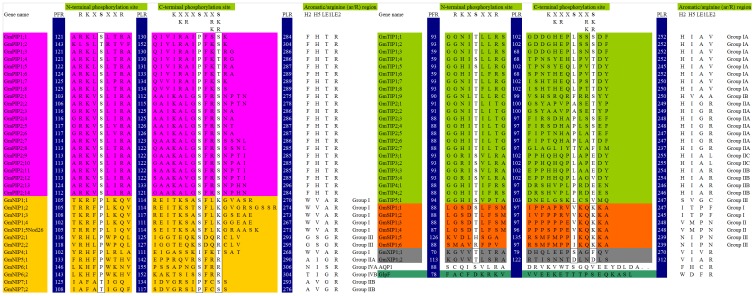
Phosphorylation sites in C-terminal domain, N-terminus and aromatic/arginine (ar/R) region in GmMIPs.